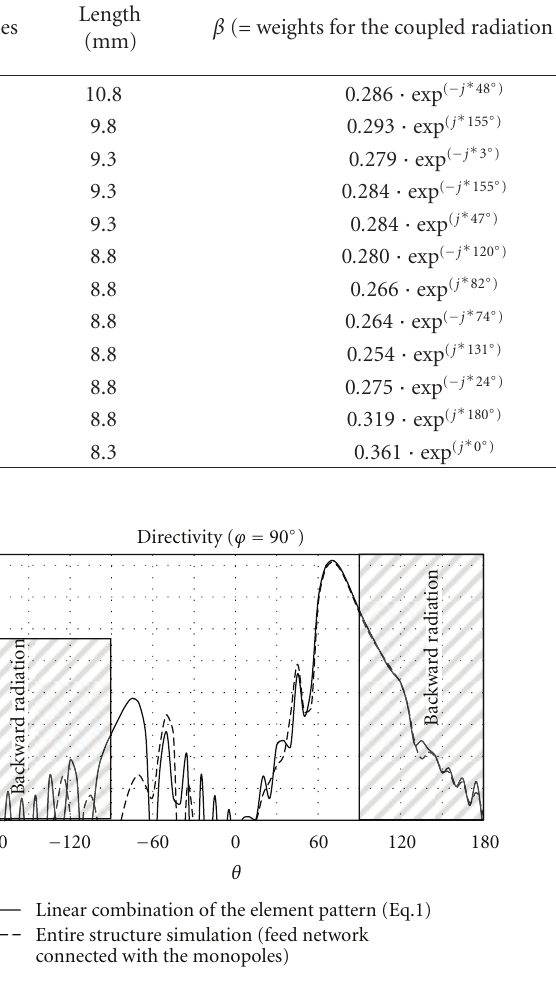
Figure 8: Simulated radiation pattern (directivity) comparison at f = 5 . 6GHz.